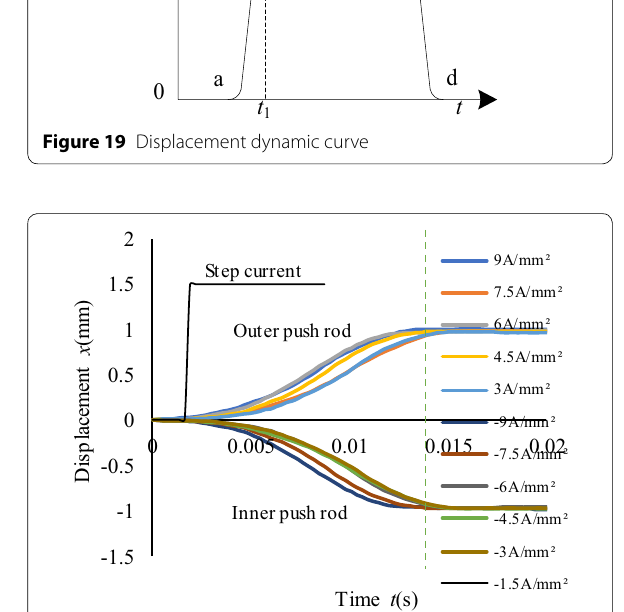
-0.06 Figure 18 Force response time curve of inner and outer rod